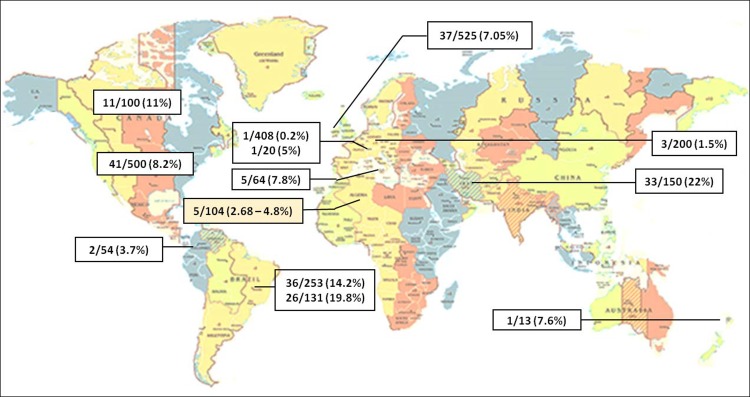
Molecular detection of Leptospira spp. DNA in the urines of dogs, worldwide.Germany, 3/200 (1.5%) [8], the USA, 41/500 (8.2%) [14], Teheran (Iran), 33/150 (22%) [34], Canada, 11% (11/100) [35], Sicily (Italy), 5/64 (7.8%) [36], Ireland, 37/525 (7.05%) [37], Porto Alegre City (Brazil), 36/253 (14.2%) [38], Switzerland, 1/20 (5%) [39], Colombia 2/54 (3.7%)[40], New Caledonia, 1/13 (7.6%) [41], Brazil, 26/131 (19.8%) [42], Switzerland, 1/408 (0.2%) [43], Algiers (Algeria), 5/104 (2.68% - 4.8%) [Present work].